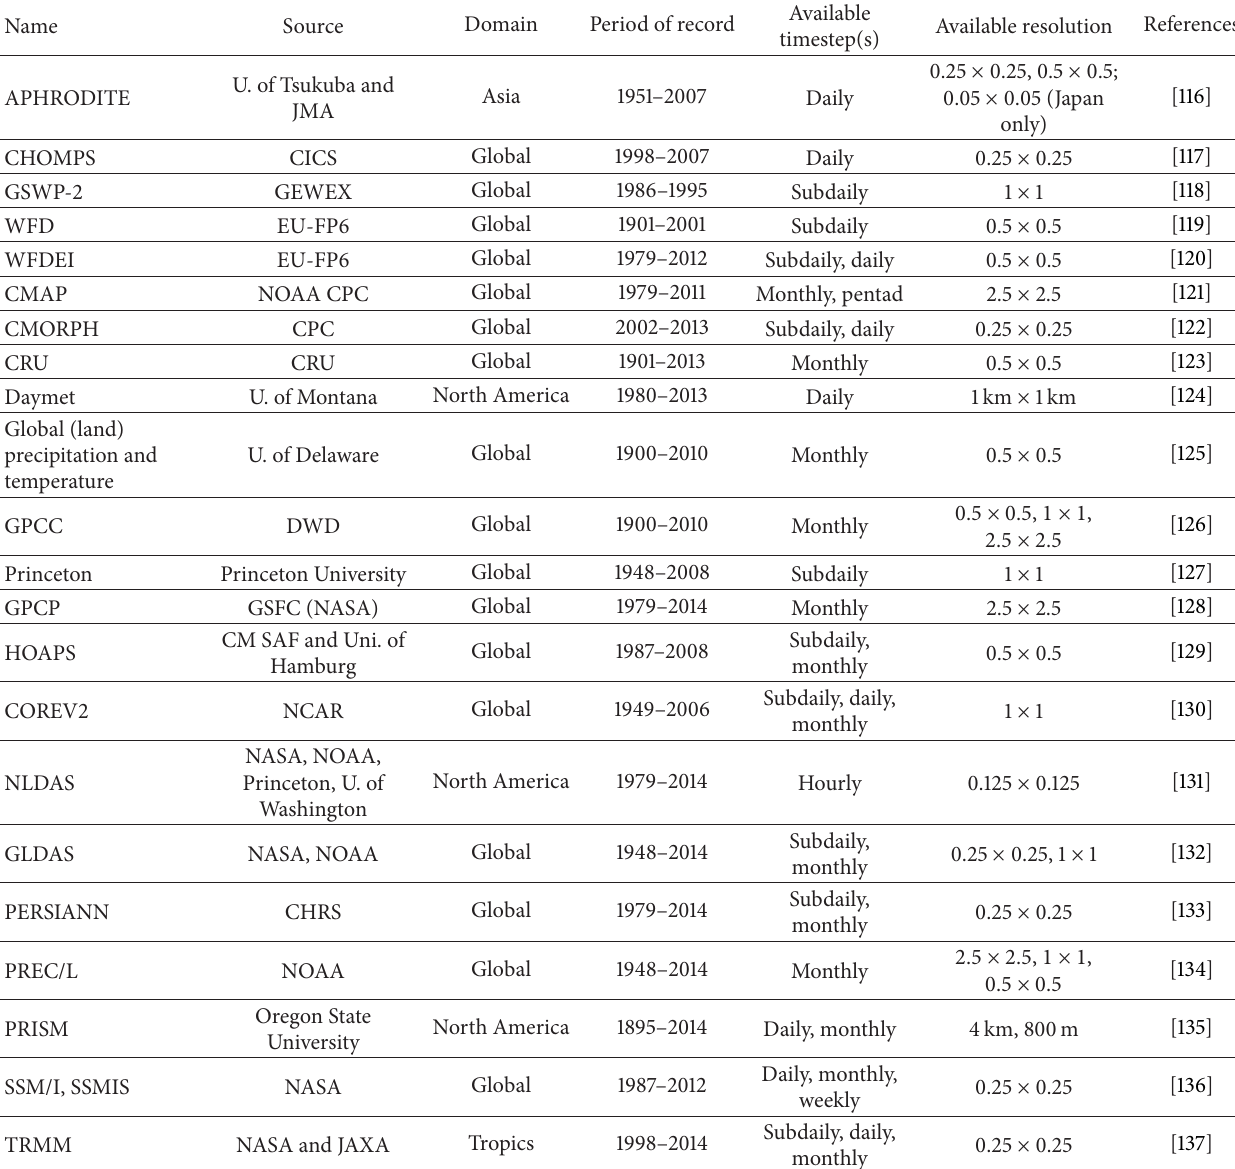
Table 3: Summary of precipitation